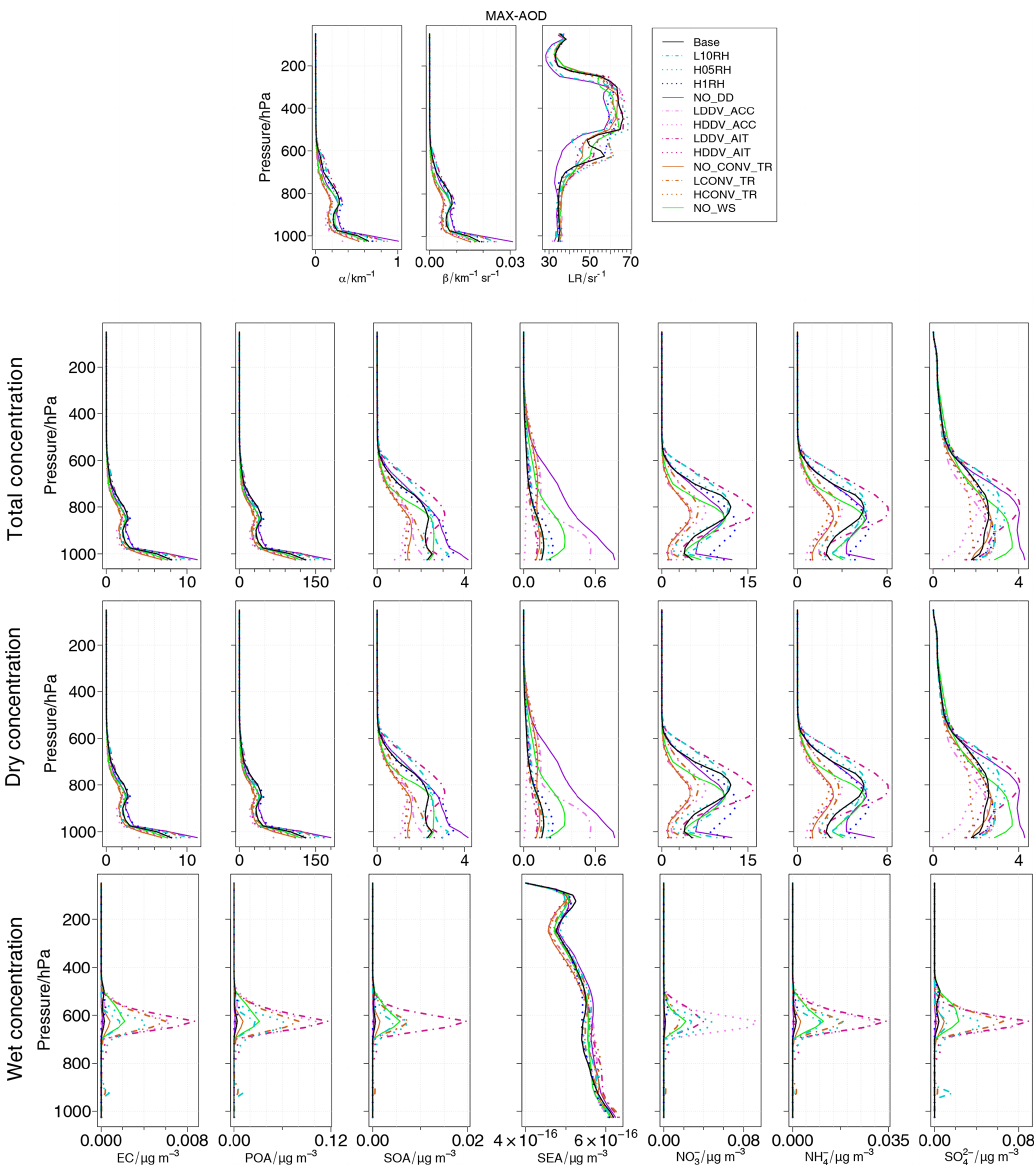
Figure 3. Profiles over the Max-AOD location. Top row shows the α (left), β (centre), and LR (right). From second to bottom rows, columns display concentration of EC, POA, SOA, SEA, NO − , NH − , and SO 2 − . The second row is for total concentration, the third for dry, and 3 4 4 the bottom for wet. The solid black line represents the base case. The blue colour is for RH sensitivity: the dotted dark is the high, in 1% (H1RH); the dotted light is the high, in 0.5% (H05RH); and the dotted–dashed light is the low, in 10% (L10RH). The violet colour is for dry deposition. The solid dark is the no dry deposition (NO_DD). The remaining dark are for the modification of DDV in the Aitken mode: the dotted is the high (HDDV_AIT), and the dotted–dashed is the low (LDDV_AIT). Similar but in light violet is for the accumulation mode: the dotted is the high (HDDV_ACC), and the dotted–dashed is the low (DDV_ACC). The brown colour is for sub-grid convective transport: the solid is without it (NO_CONV_TR); the dotted is the high case (HCONC_TR); and the dotted–dashed is the low (LCONV_TR). The solid green represents the wet scavenging turned off